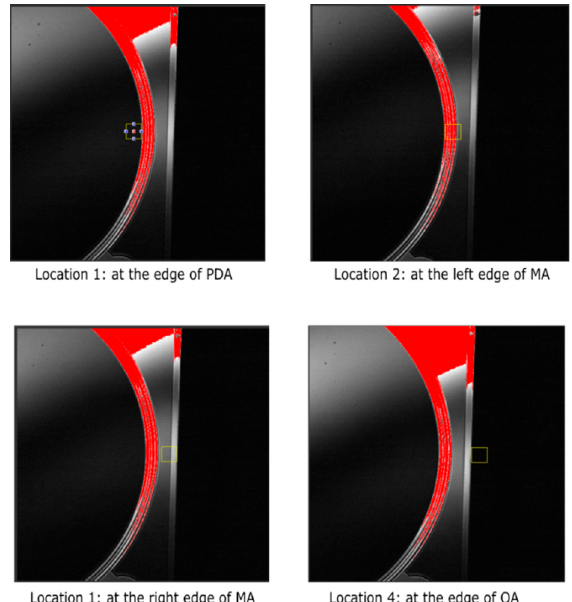
Figure 4. The location of each region of interest (ROI) in the photodiode.